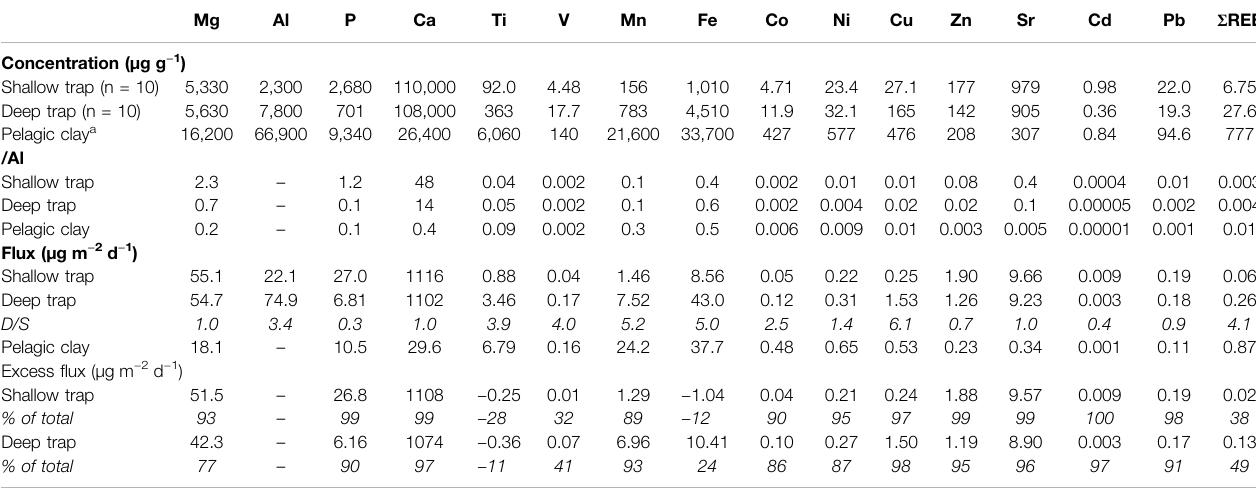
TABLE2| Averageelementconcentrations, fl uxes,andexcess fl uxesinshallowanddeeptrapsatthebaseoftheJA06seamount.Thecorrespondingvaluesforpelagicclay sampled at the same seamount are provided for comparison. Mg Al P Ca Concentration (µg g − 1 ) Shallow trap (n (cid:2)